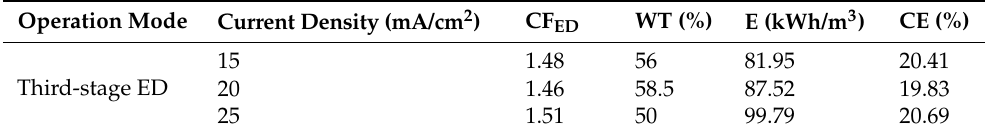
Table 4. Concentration factor, water transport, energy consumption, and current efficiency of the third-stage ED concentration.